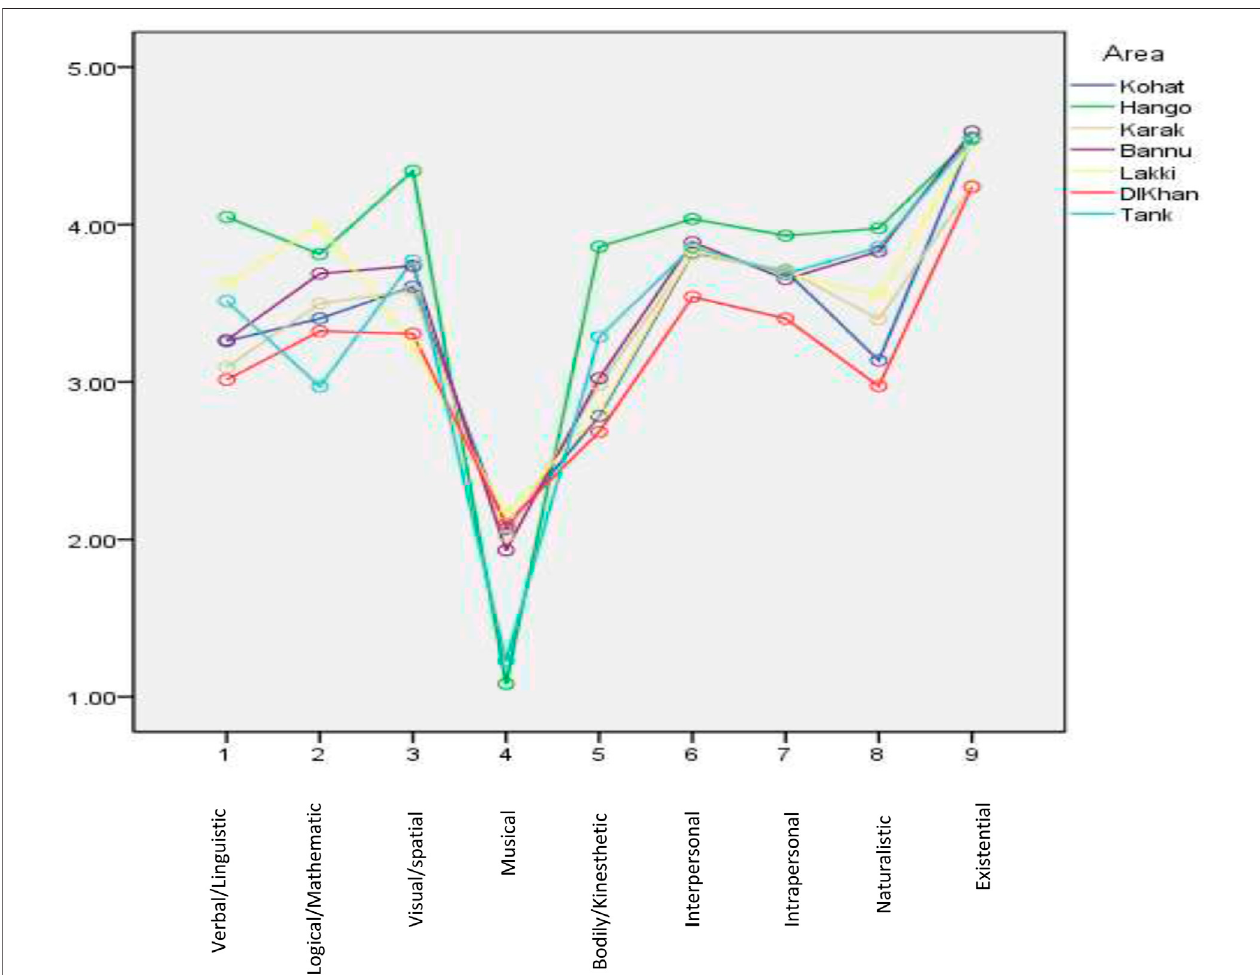
FIGURE 2 | Self-estimates of multiple intelligences (based on mean score).